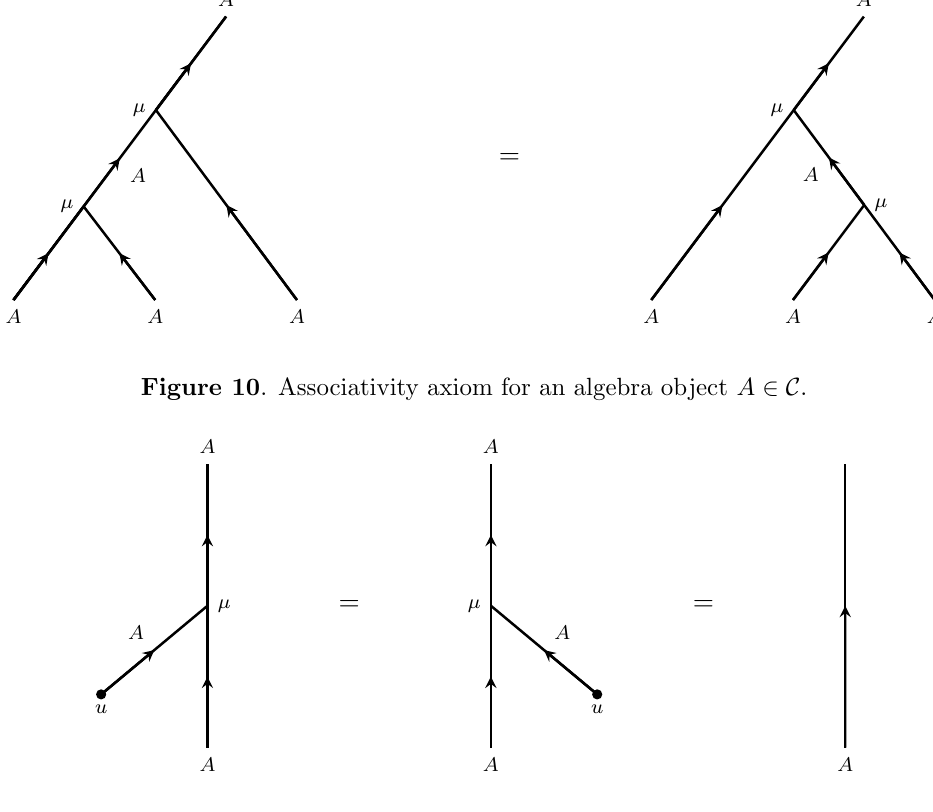
Figure 11 . Unit axiom for an algebra object A 2 C